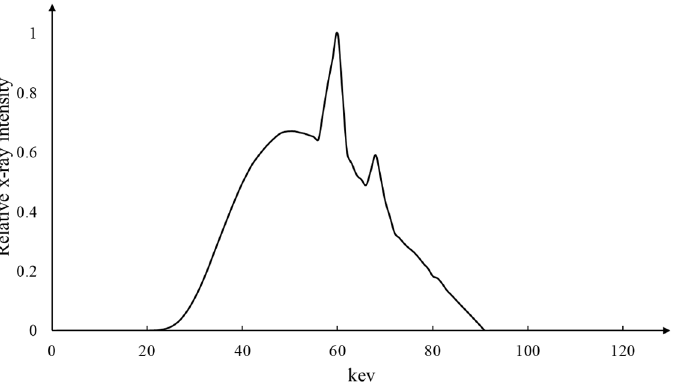
Figure 8. The X-ray spectrum emitted from the X-ray tube of the dental CT scanner (RAYSCAN α +, Ray, Republic of Korea).